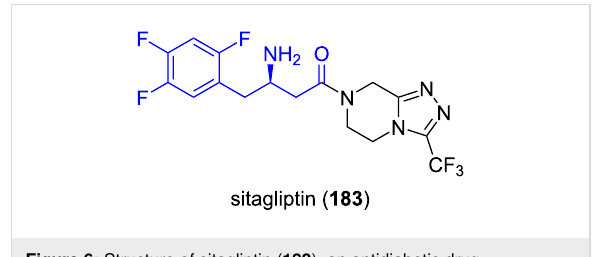
Figure 6: Structure of sitagliptin ( 183 ), an antidiabetic drug.